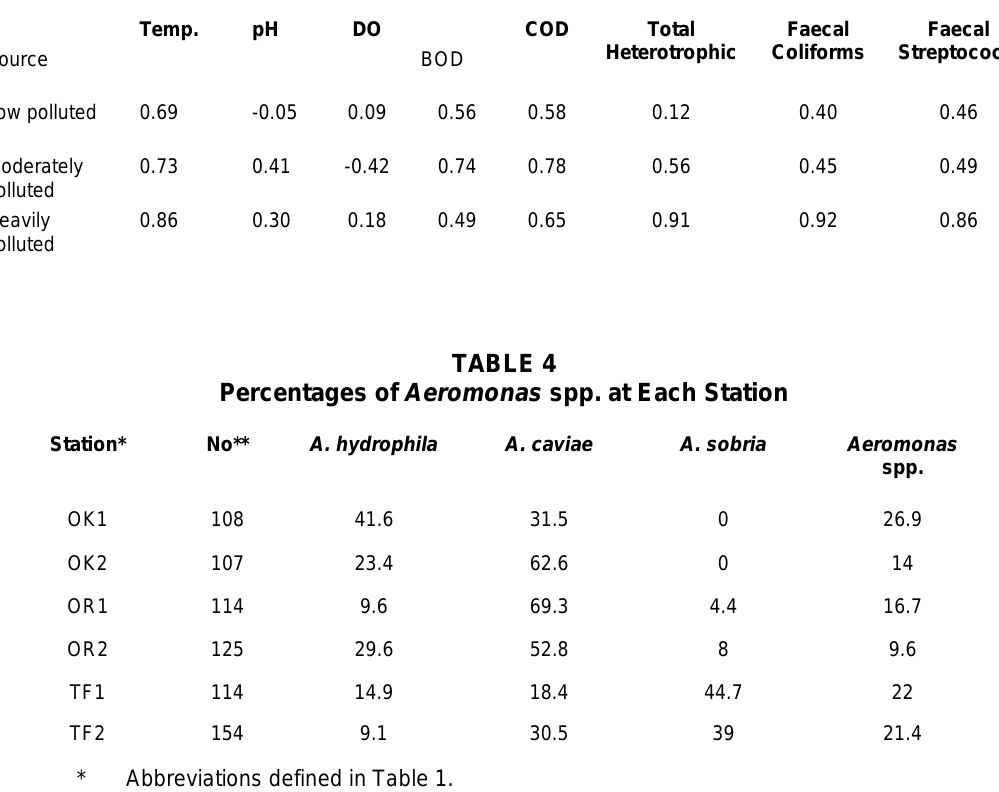
Pearson Correlation Coefficient Between Mesophilic Aeromonads and Various Biotic and Abiotic Characteristics